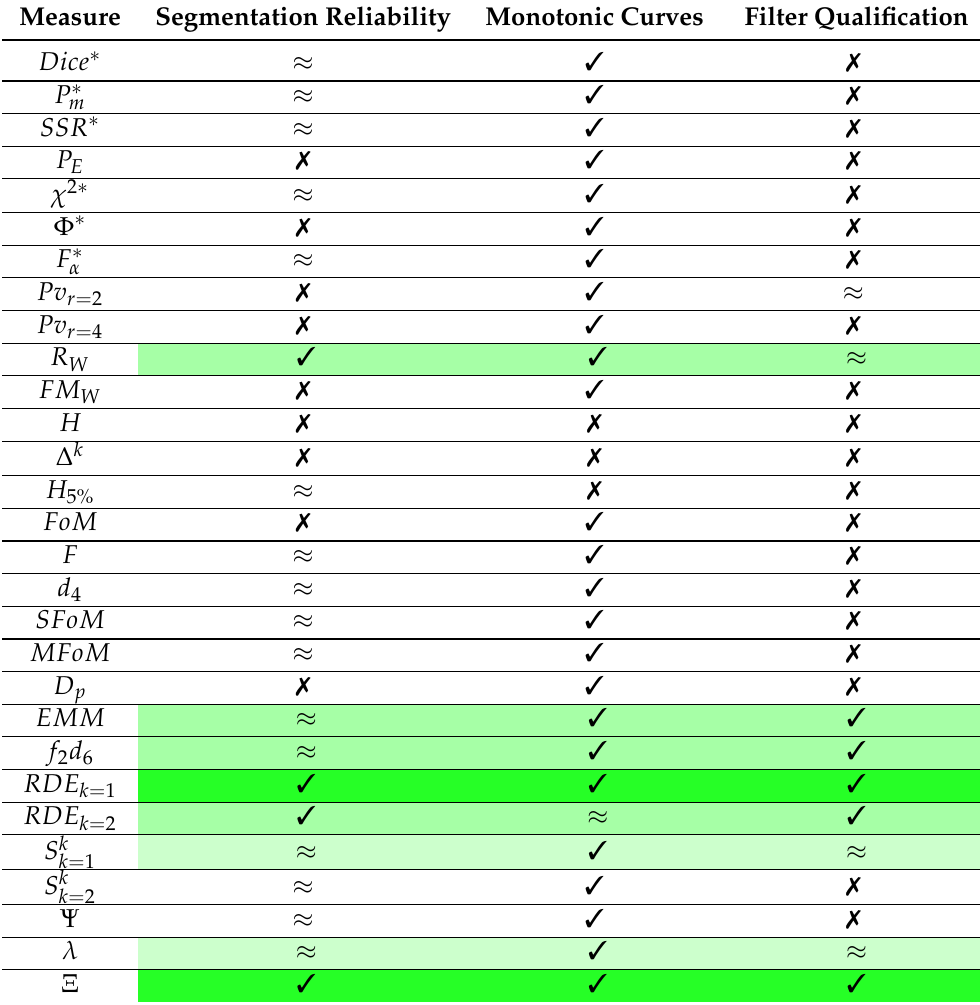
Table 5. Reliability of the reviewed edge detection evaluation